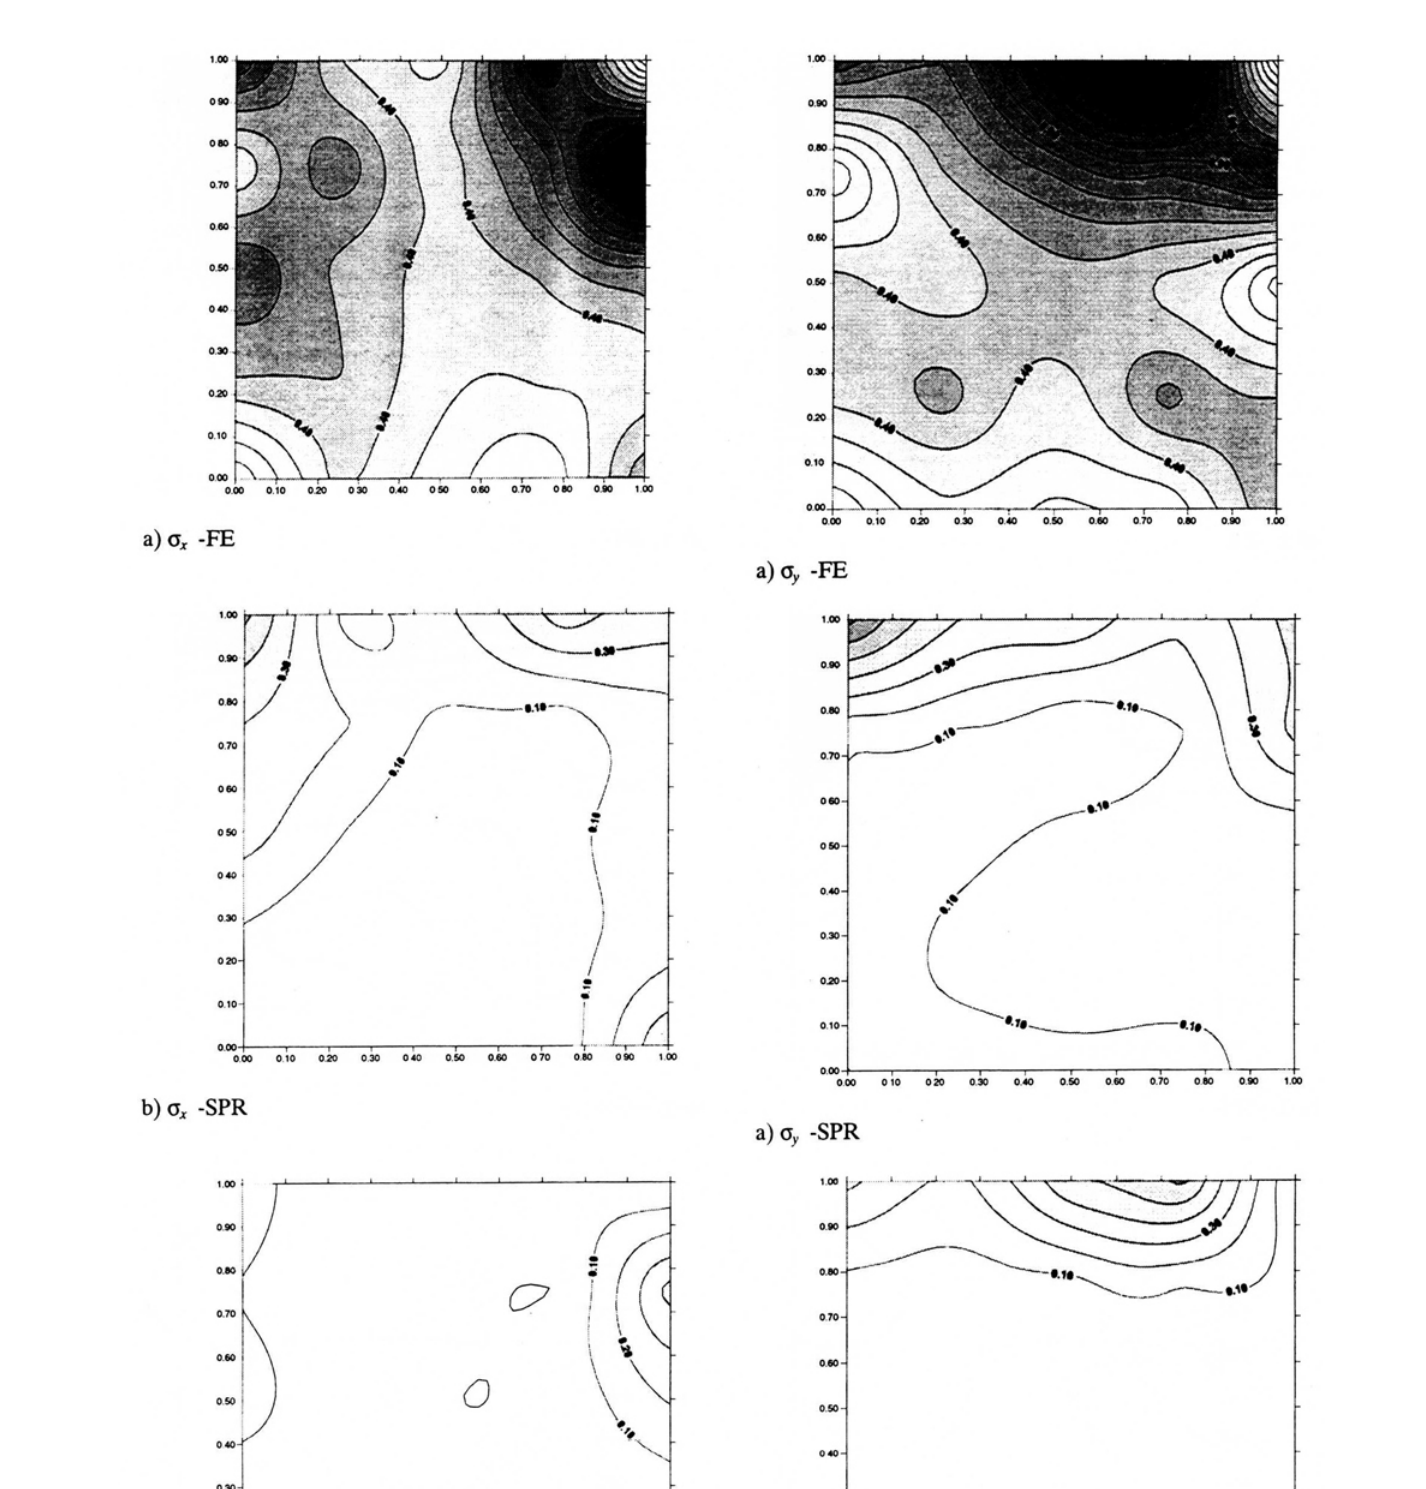
Fig 4. Distribution of absolute error in flux component <rx using triangular elements